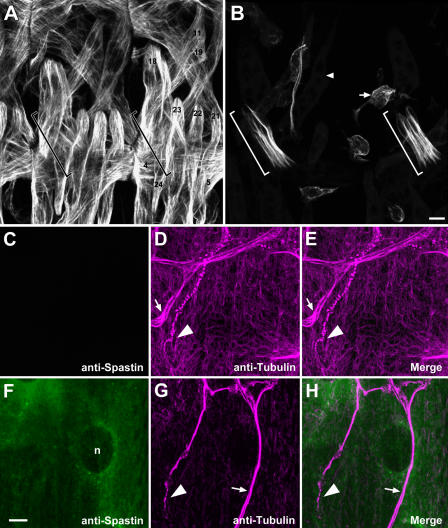
Spastin Overexpression in Muscles Erases the Microtubule Network(A) An antibody against β3-tubulin stains body wall muscles and chordotonal cap cells in stage 16 wild-type embryos. Two abdominal hemisegments are shown; muscle fiber numbers are labeled in one. The cap cells (brackets) are difficult to distinguish in this panel because of high levels of muscle tubulin staining. They extend diagonally from about the middle of muscle 18 to muscle 22. Anterior is to the left, and dorsal is up.(B) When Spastin is overexpressed in muscles (genotype: G14-GAL4/+; T32/+), β3-tubulin staining is very weak and has a disorganized pattern in most muscle fibers, but an intact microtubule network is still present in the cap cells, which do not express this driver (brackets). The muscle fibers are misshapen and partially (arrowhead) or completely (arrow) detached from their insertion sites.(C–H) Similarly, the microtubule network (recognized by antibodies to α-tubulin) is almost eliminated by high-level Spastin expression in third instar larval muscles. Larvae of genotype UAS-spastin/MHC-GS-GAL4213-3; spastin5.75/TM3Ser-ActGFP overexpress Spastin protein specifically in muscles to varying degrees. Wild-type larval muscles had undetectable levels of Spastin using pAb 1239 (C) and displayed a dense network of microtubule bundles in the muscle (D and E), as well as in trachea (D, arrow) and neurons (D, arrowhead denotes a terminal arbor). In contrast, larval muscles expressing high levels of Spastin (F) show only faint muscle microtubule staining (G and H), while tracheal (G, arrow) and neuronal (G, arrowhead) staining remain robust.